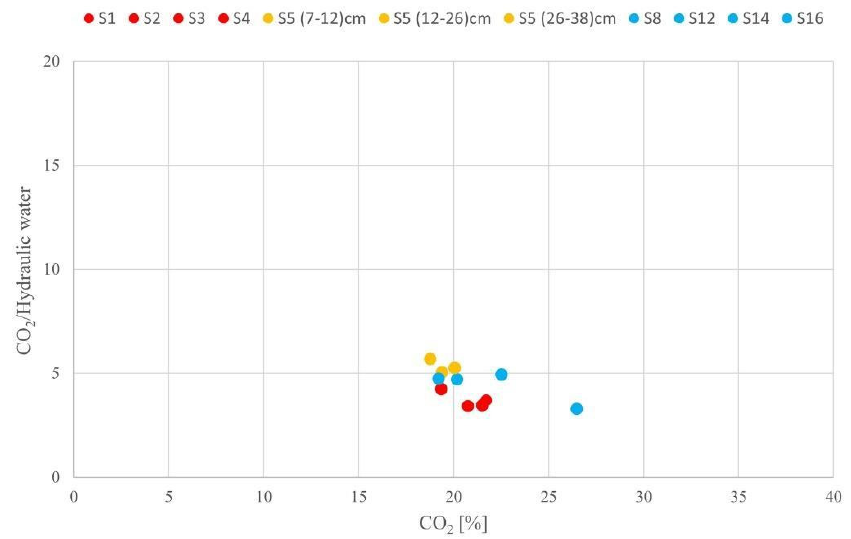
Figure 10. Plot of CO 2 /H 2 O ratio vs. %CO 2 measured on the enriched binders of mortar samples by TGA analysis.